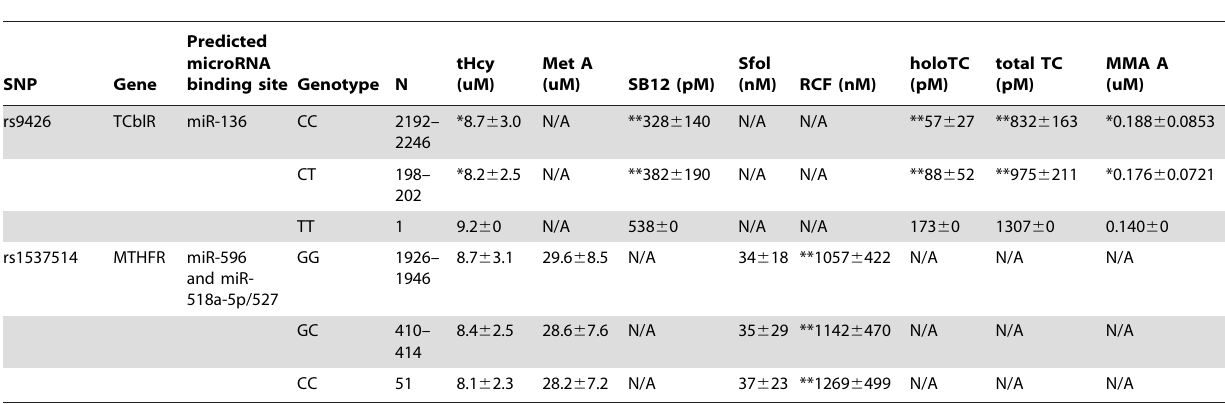
Table 3. Summary metabolite data for individuals with different genotypes at significantly associated single nucleotide polymorphic (SNP) loci that are within predicted microRNA target